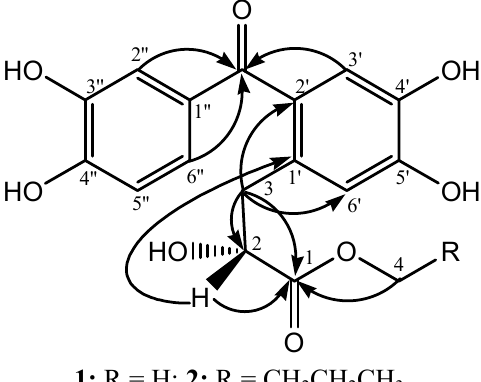
Figure 2. Structures and key HMBC (H → C) correlations of compounds 1 and 2